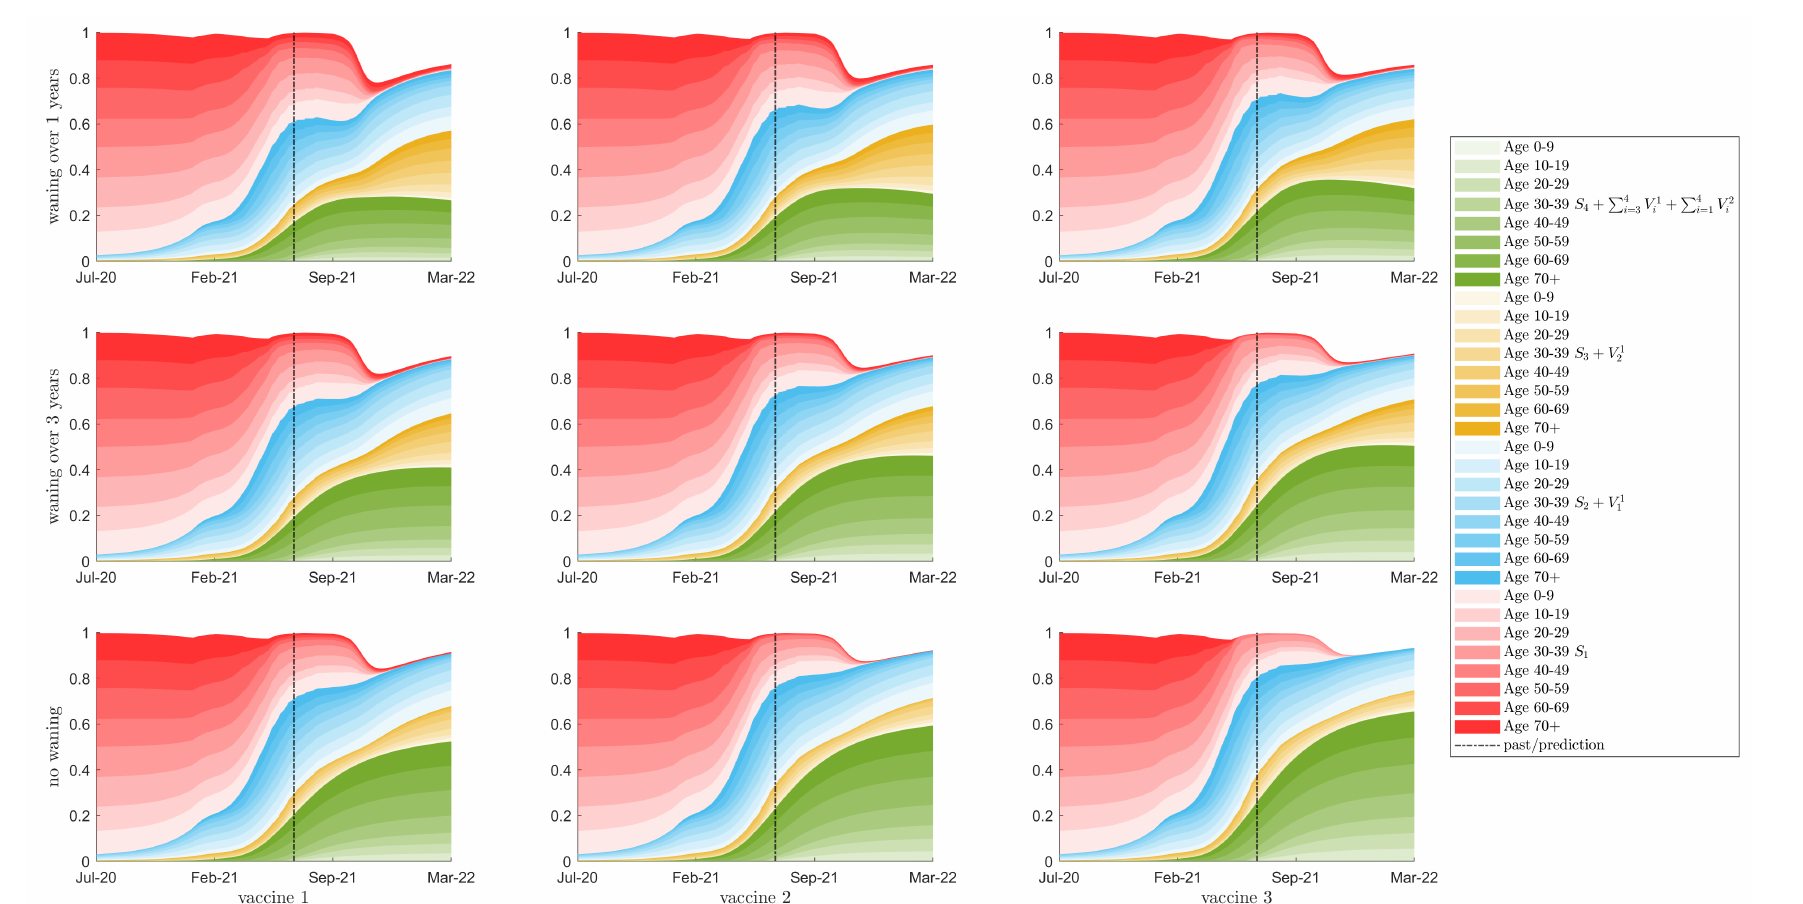
Figure 4. Distribution of Immunity, with a 20% relaxation of κ starting in September 2021. Showing immune status of uninfected individuals as a percent of the total population for 10 year age classes, with colour intensity corresponding to age class. The colours represent the immunity of the population from green, the fully immune population, through yellow and blue to red, the fully susceptible population. The top row is waning of immunity by one year between consecutive classes; the middle row is waning of immunity of three years; the bottom row is no waning of immunity. Columns left to right represent vaccines 1 to 3, respectively. The vertical bar denotes the beginning of the prediction